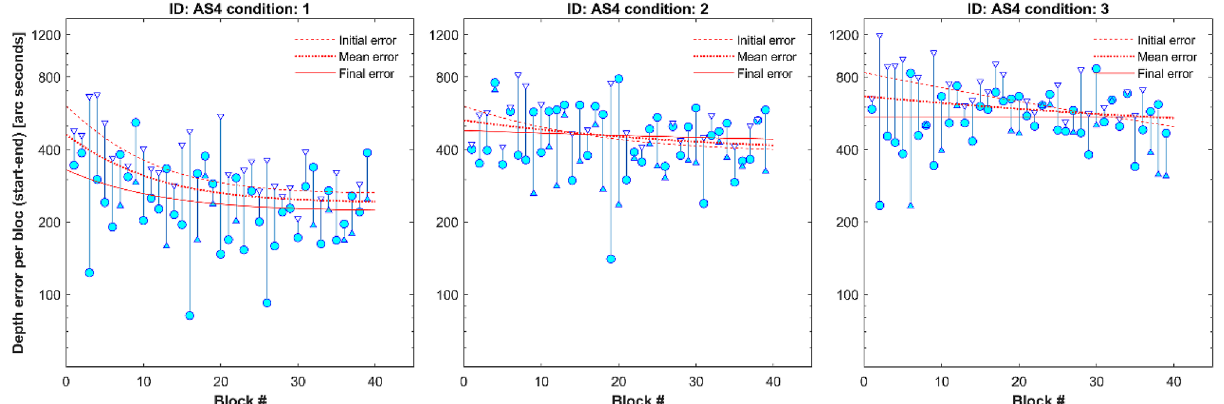
Figure 3. Across-block learning example (AS4, strabismic stereo-anomalous participant). From left to right, results under Condition 1, 2 and 3. Results from each block are represented as a vertical line, with a triangle on one end indicating the depth error at the beginning of the block and a circle indicating the depth error at the end of the block. A triangle at the top indicates depth error reduction within a block. Three exponential plots have been superimposed and represent across-block learning. The fits represent an exponential function to the initial error at each block (dotted line), mean error (hashed line), and final error (continuous line).